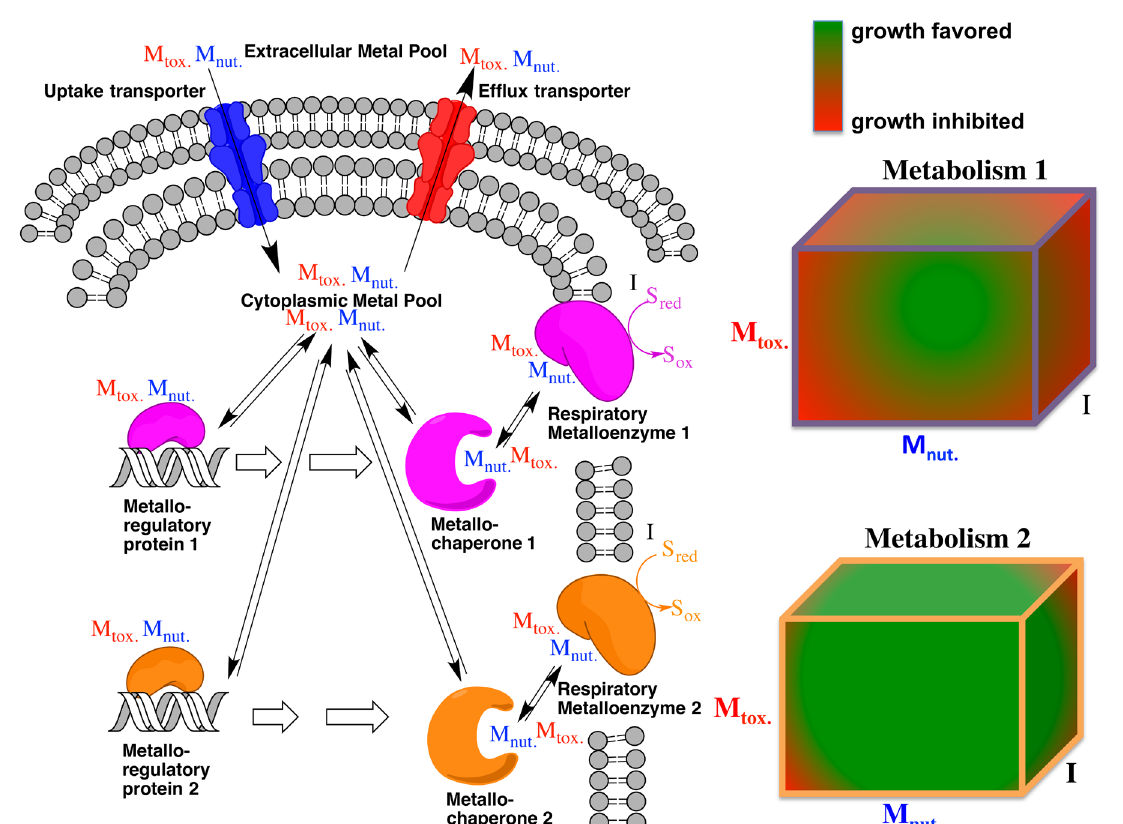
Figure 3. Toxic metals (M ) interfere with the metabolism of essential, nutrient metals (M tox. depending on the metabolism. For example, metabolism 1 and metabolism 2 could be aerobic respiration, nitrate reduction, sulfate reduction, and photosynthesis. Similarly, other metals (I) can serve as antimetabolic inhibitors of respiratory enzymes, competing with substrate (S binding and turnover to product (S ). Depending on the inhibitory potency of the toxic metal (M ox (M ), and the inhibitory potency of a respiratory inhibitor (I), different metabolisms will have different environmental ranges in response to nut. metal